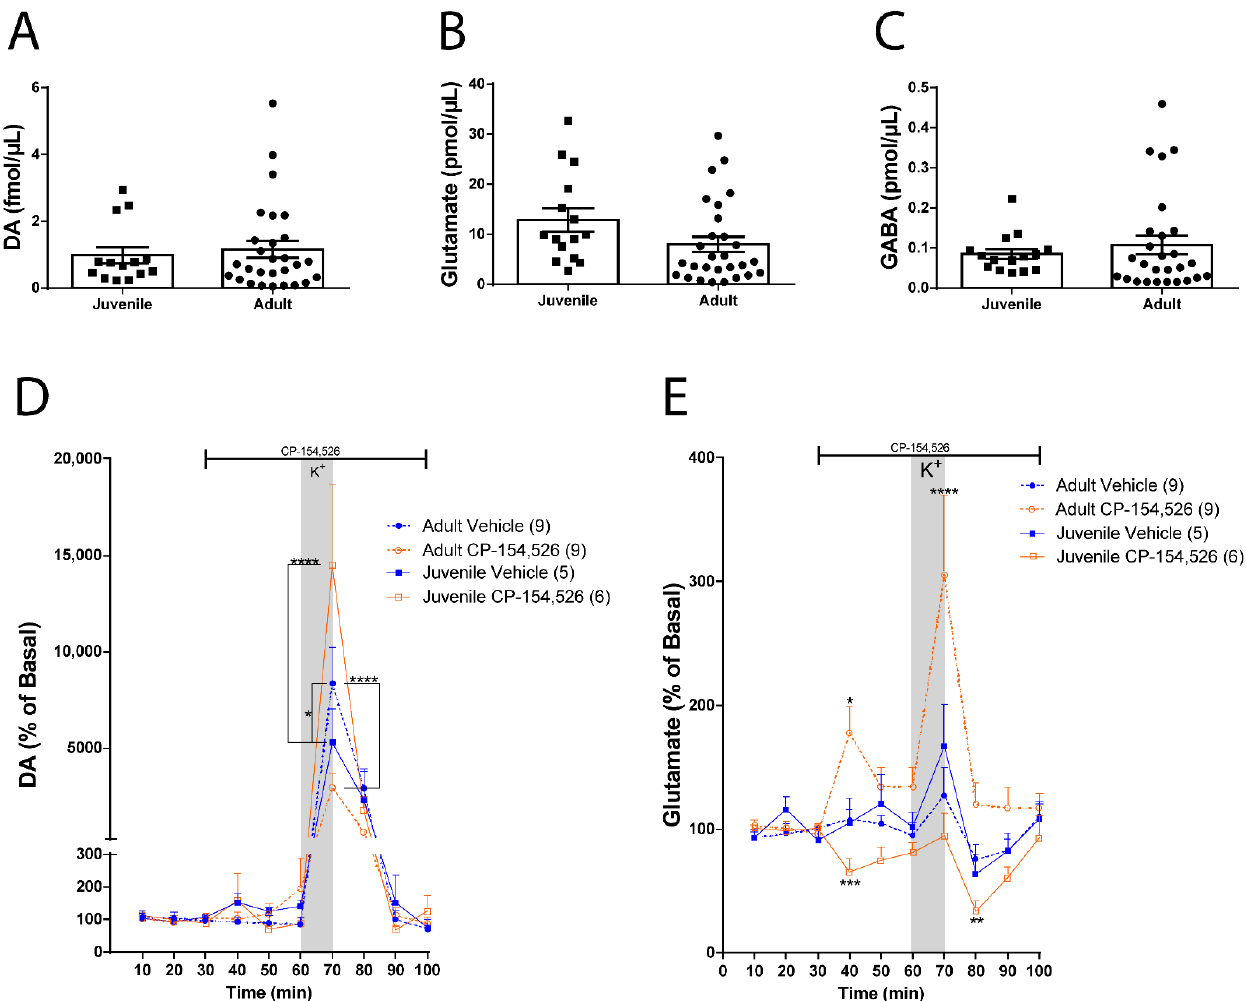
Figure 3. Changes in CRF-R1 role in juvenile versus adult rats. Comparison between juvenile versus adult rats. Measurement of NAc extracellular neurotransmitter basal levels and CRF-R1 role using in vivo microdialysis. ( A ) The average of the first 3 values for each of NAc DA levels was compared between juvenile ( n = 14) and adult rats ( n = 28). Non-paired Student ’ s t-test revealed that DA basal levels were not different in juvenile animals compared to adults (t = 0.4519, df = 40, p = 0.6538). ( B ) The first 3 values for each NAc glutamate level were averaged and compared between juvenile ( n = 15) and adult rats ( n = 28). Non-paired Student ’ s t-test revealed that basal glutamate levels were not different in juvenile animals compared to adults (t = 1.802, df = 41, p = 0.0789). ( C ) The first 3 values for each NAc GABA level were averaged and compared between juvenile ( n = 15) and adult rats ( n = 28). Non-paired Student ’ s t-test revealed that GABA basal levels were not different in juvenile animals compared to adults (t = 0.6792, df = 40, p = 0.5009). Measurement of NAc extracellular neu- rotransmitter levels using in vivo microdialysis, the vertical gray bars indicate the time of NAc local infusion of 70 mM K+-aCSF, and the horizontal black lines indicate the time of intra-NAc infusion of the antagonist or vehicle. ( D ) Adult versus juvenile NAc DA levels in the presence of aCSF (Ju- venile, continued blue line, n = 5; Adult, blue dotted line, n = 9) and 10 µM of CP154,526 (Juvenile, orange continued line, n = 6; Adult, orange dotted line, n = 9). DA levels were normalized to the average of the first 3 values for each condition and expressed as percentage. Two-way ANOVA revealed a main effect of treatment (F (3, 25) = 3.480, p = 0.0308), a main effect of time (F (9, 225) = 42.06, p < 0.0001), and treatment × time interaction (F (27, 225) = 4.618, p < 0.0001; **** p < 0.0001, * p = 0.0360, Bonferroni post hoc test). ( E ) Adult vs. juvenile NAc glutamate levels in the presence of aCSF (Juvenile, blue continued line, n = 5; Adult, blue dotted line, n = 9) and 10 µM of CP154,526 (Juvenile, orange continued line, n = 6; Adult, orange dotted line, n = 9). Glutamate levels were nor- malized to the average of the first 3 values for each condition and expressed as percentage. Two-